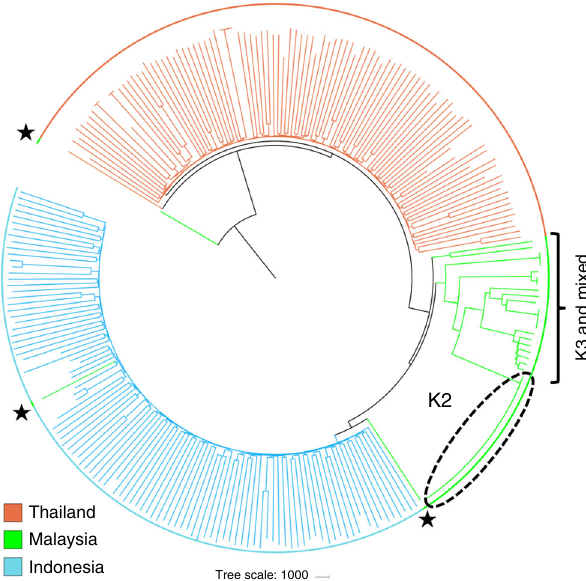
Fig. 3 Neighbour-joining tree illustrating the relatedness between the P. vivax isolates from Sabah relative to Thailand and Indonesia The plot was created from genomic data on 259 high-quality infections and illustrates a rooted tree highlighting the genetically identical K2 cluster in Sabah, Malaysia. The K3 and mixed infections, which form the baseline Sabah population, are also annotated. Three putatively imported cases presenting in Sabah are annotated with black stars. One of the putatively imported infections (PY0045-C) aligned with the Papua Indonesian isolates, suggestive of importation from this region, whilst the other two cases aligned between Papua Indonesia and Sabah (PY0004-C), and close to Thailand (PY0120-C), presumably re fl ecting importation from regions not represented by the available sample